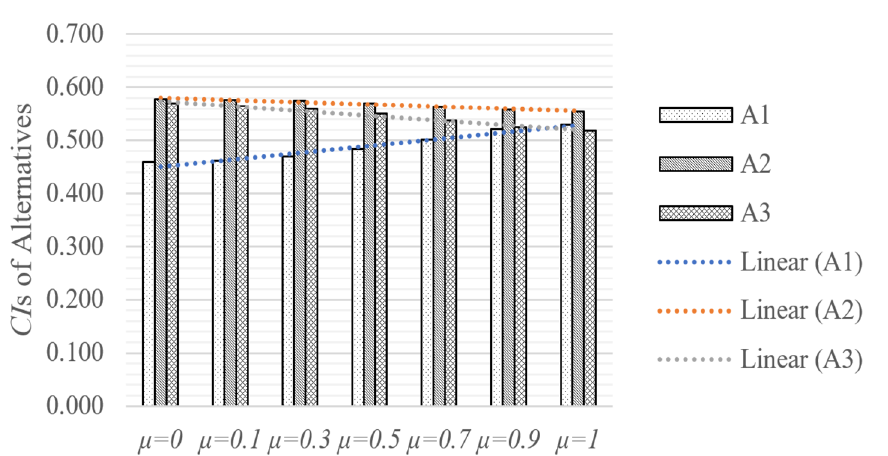
Figure 6. Closeness indices (CIs) of alternatives by different coefficient